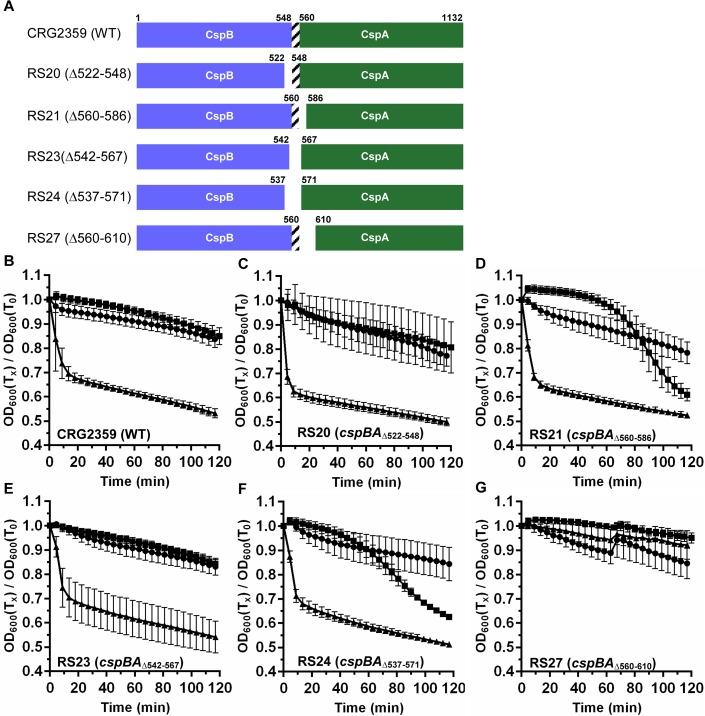
The N-terminus of C. difficile CspA is important for regulating germination in response to glycine.(A) Graphical representation of the various deletions introduced into cspBA compared to the parental, CRG2359; R20291ΔpyrE strain. Spore germination of the indicated strain was monitored at OD600 in buffer supplemented with (black circle) 30 mM glycine or (black square) 10 mM TA or (black triangle) 10 mM TA and 30 mM glycine. (B) CRG2359, (C) RS20 (cspBAΔ522–548), (D) RS21 (cspBAΔ560–586), (E) RS23 (cspBAΔ542–567), (F) RS24 (cspBAΔ537–571) and (G) RS27 (cspBAΔ560–610). Data points represent the averages from three technical triplicates of biological duplicate experiments and error bars represent the standard error of the mean.